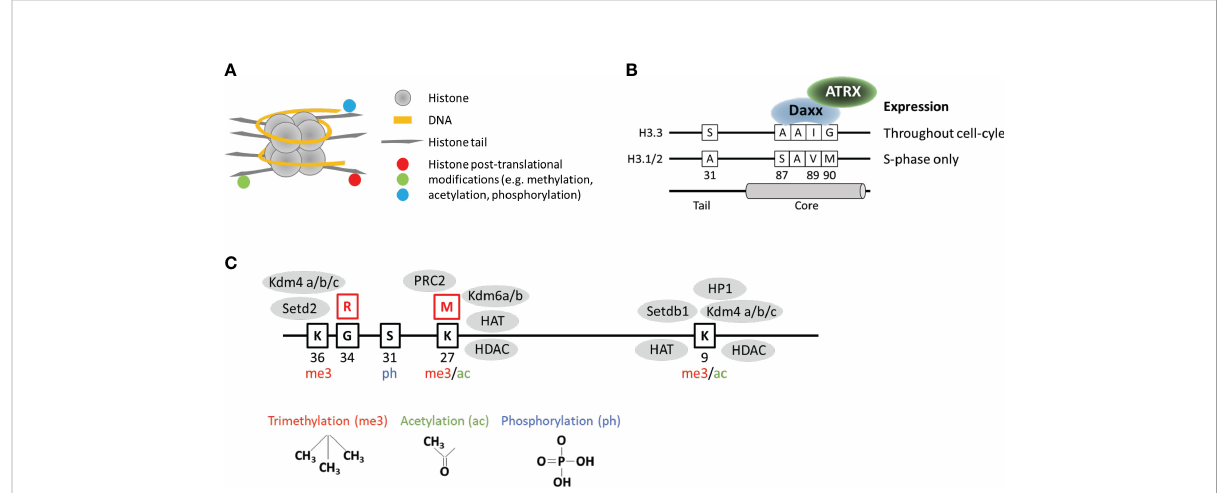
FIGURE 1 Key structural and functional features of histone H3.3. (A) DNA wrapped around nucleosome comprised of histones arranged into an octamer con fi guration with protruding tails. (B) Key features which distinguish histone variant H3.3 from canonical H3.1/2. (C) Selected amino acid residues on the H3.3 tail which are regulated by post-translational modi fi cations. Red boxes show the position of frequently mutated residues. Grey ovals represent examples of epigenetic readers, writers, and erasers known to interact with mutated and surrounding